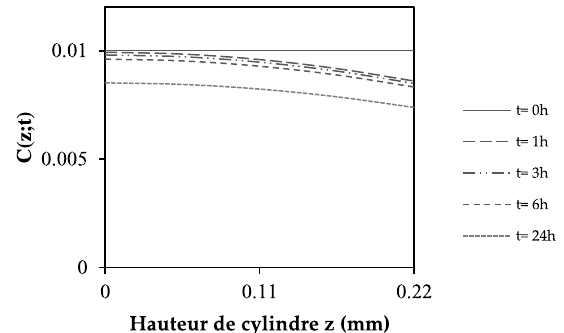
Fig. 4. Simulation of concentration pro fi les (cid:4) Case of desorption of the EOCa in the RC